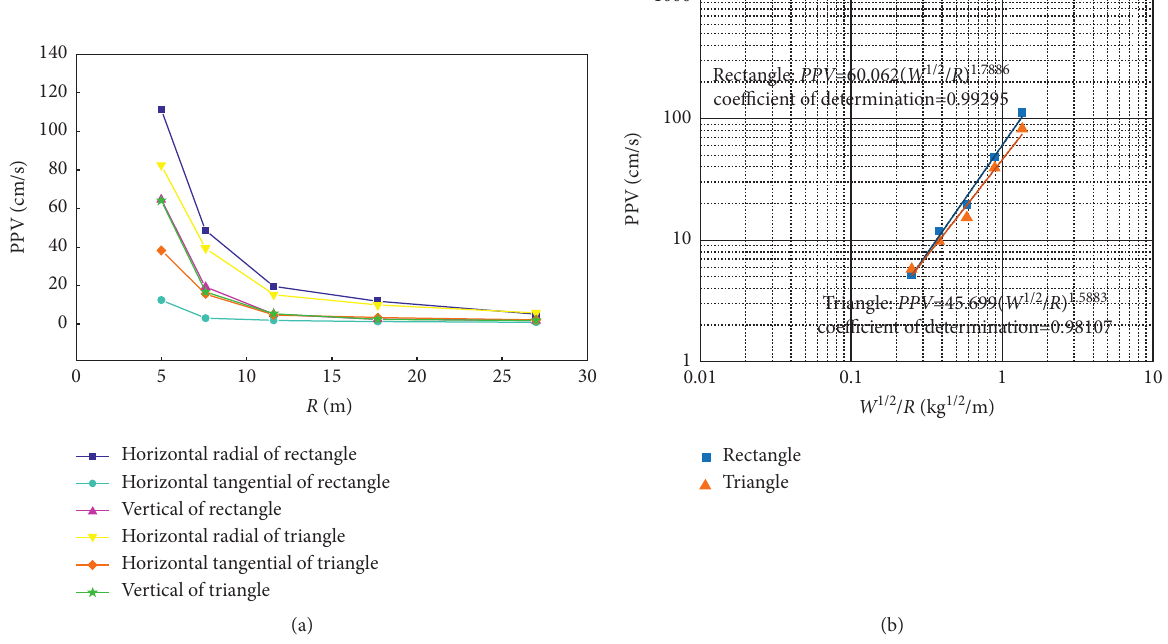
� 1. (b) K � 2. (c) K � 5. r . (a) K r r r